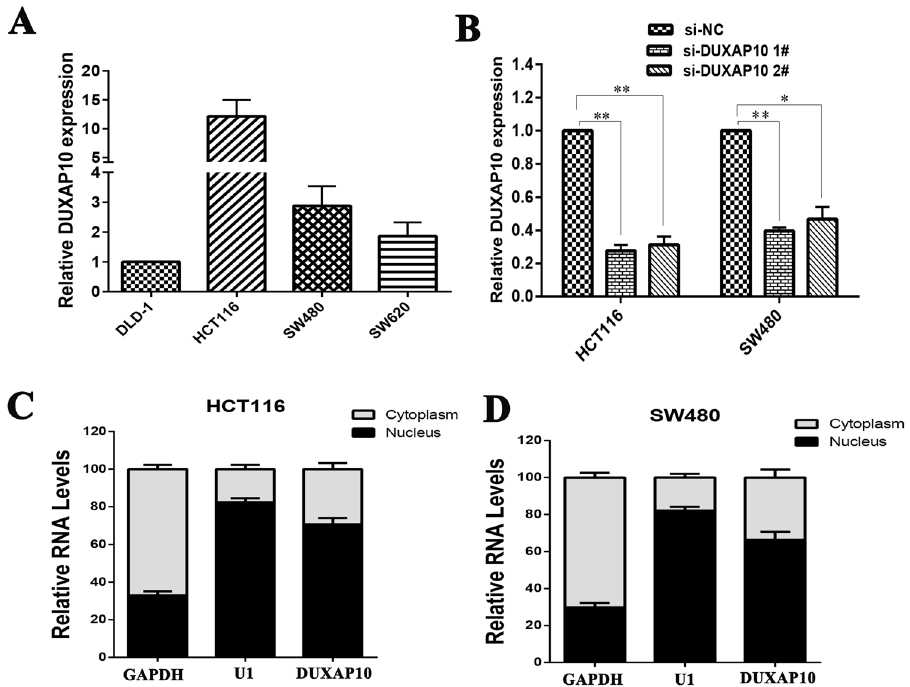
Figure 2. Relative DUXAP10 expression levels in CRC cell lines. ( A ) Analysis of DUXAP10 expression levels in CRC cell lines (DLD-1, HCT116, SW480 and SW620) by qPCR. (B ) qPCR analysis of DUXAP10 expression levels following treatment of HCT116 and SW480 cells with siRNAs against DUXAP10. ( C ) Relative DUXAP10 levels in cell cytoplasm or nucleus of HCT116 and SW480 cell lines were detected by qPCR. Bars: s.d., * P < 0.05, ** P <